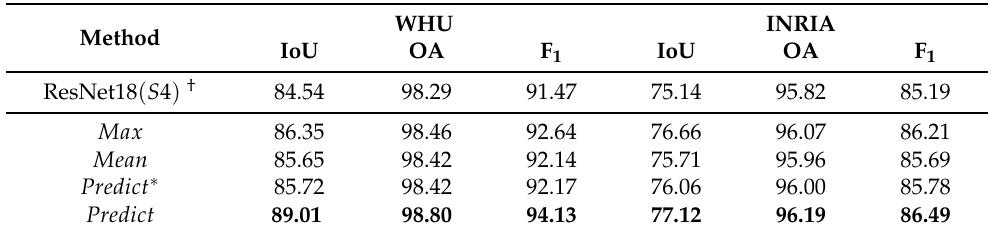
Table 7. Evaluations on different ways of generating token probabilistic maps in our method. †: Without auxiliary loss to generate probabilistic